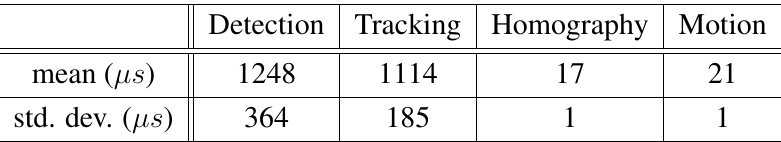
Table 1. Measured processing overhead of the head tracking approach. Each column shows the mean and standard deviation of the required processing time expressed in